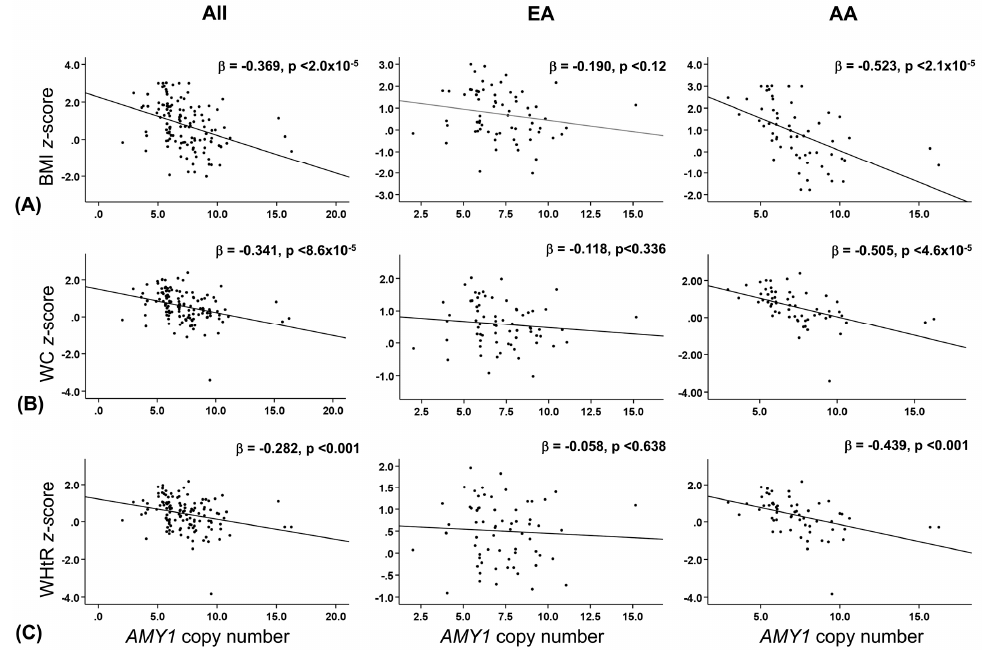
Figure 3. Relationship between AMY1 copy number and obesity measurements. Association of AMY1 copy number with ( A ) BMI z -score, ( B ) WC z -score, and ( C ) WHtR z -score in European American, African American, and study population. Standardized β -coefficient value was used to quantify the association. When considering interaction, a p value <0.05 is significant.